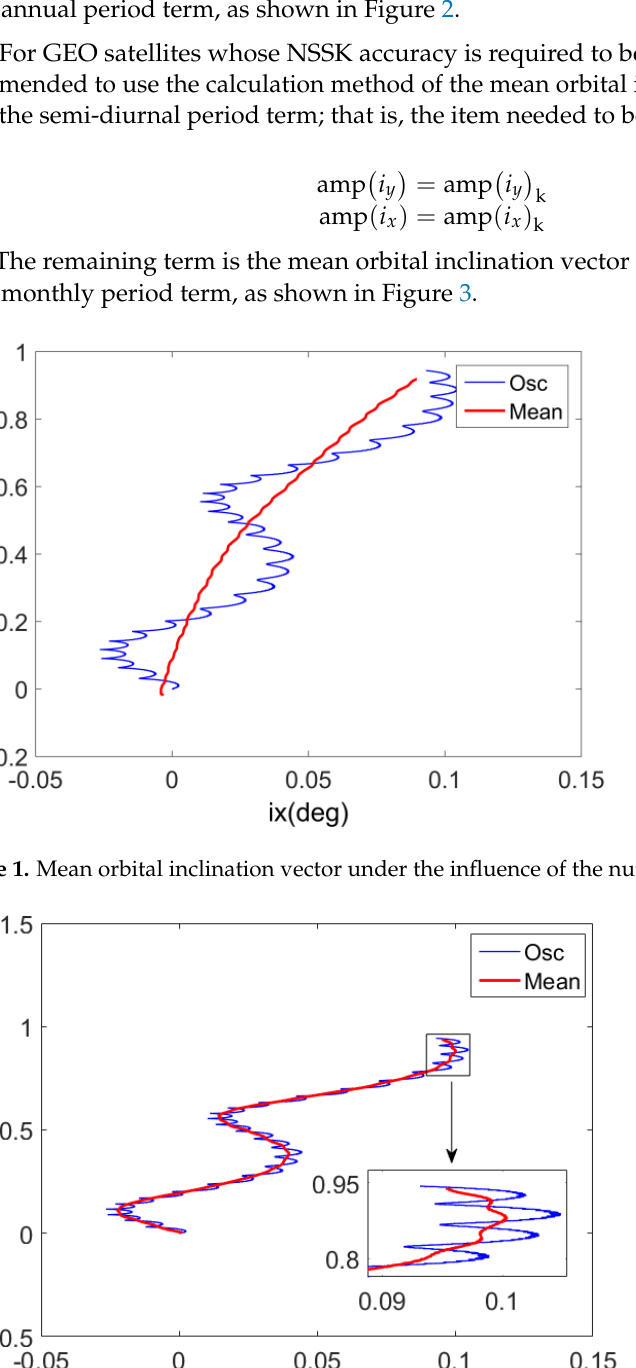
Figure 3. Mean orbital inclination vector under the influence of the semi-monthly period term. 3. North/South Station Keeping Control by Electric Propulsion with Manipulator 3.1. Basic Concepts The SK of the GEO satellite is divided into north/south station keeping (NSSK) and east/west station keeping (EWSK). The NSSK is also called orbital inclination keeping, which is the out-of-plane control; the EWSK includes the mean longitude keeping and the eccentricity vector keeping, which is the orbital in-plane control. The required velocity increment of the satellite’s orbital semi-major axis keeping is no more than 2 m/s per year; the required velocity increment of satellite’s orbital eccentricity vector keeping is no more than 2 m/s per year; the required velocity increment of the satellite’s orbital inclination